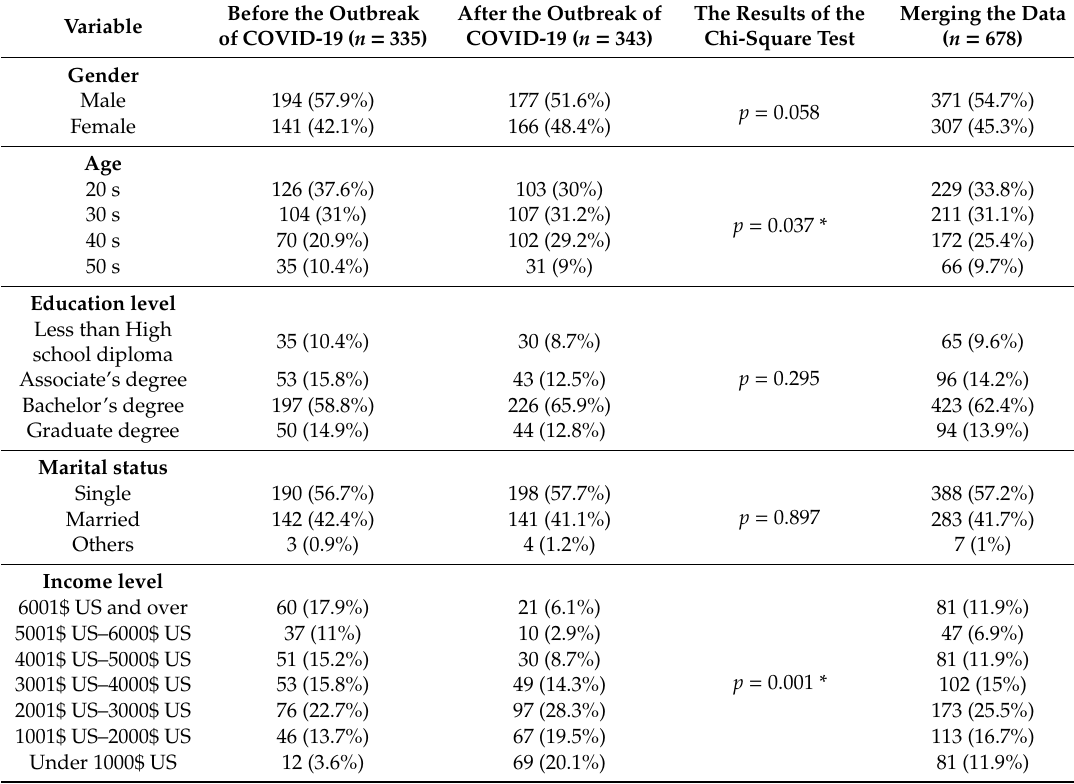
Table 1. Profile of the survey